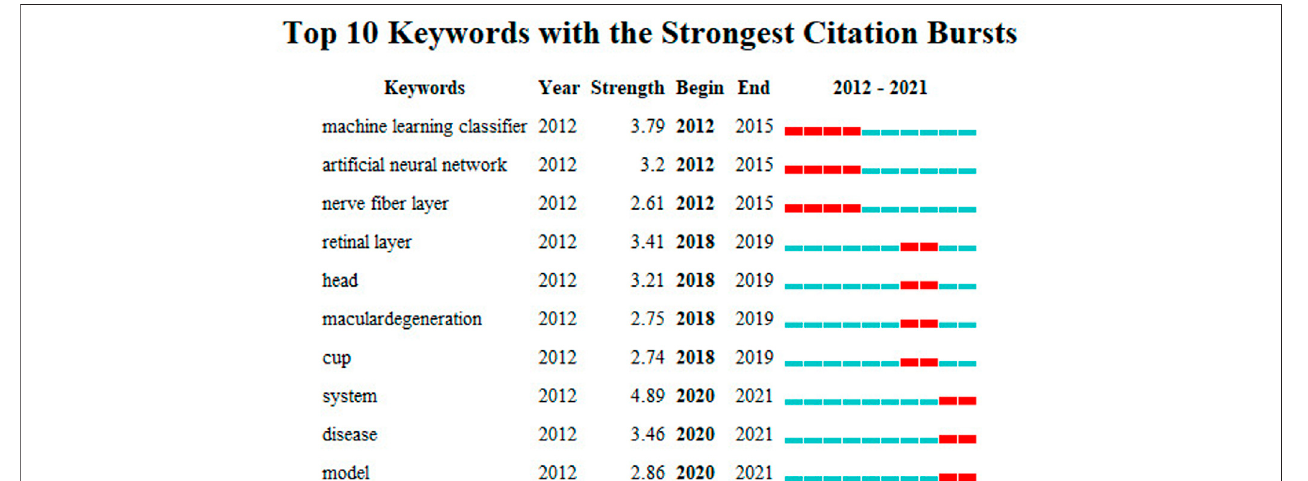
FIGURE 6 | Keywords with the strongest citation bursts for publications on the use of AI in the diagnosis of ophthalmic diseases from 2012 to 2021.